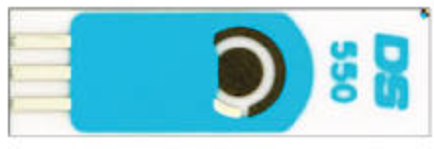
Figure A1. Impedance sensor